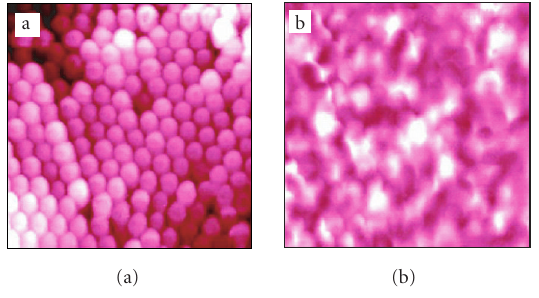
Figure 16: Shear-force AFM (a) and apertureless SNOM (b) of a closed monolayer of 430nm styrene-acrylamide copolymer latices on mica showing di ff erent brightness of the optical contrast due to di ff erent